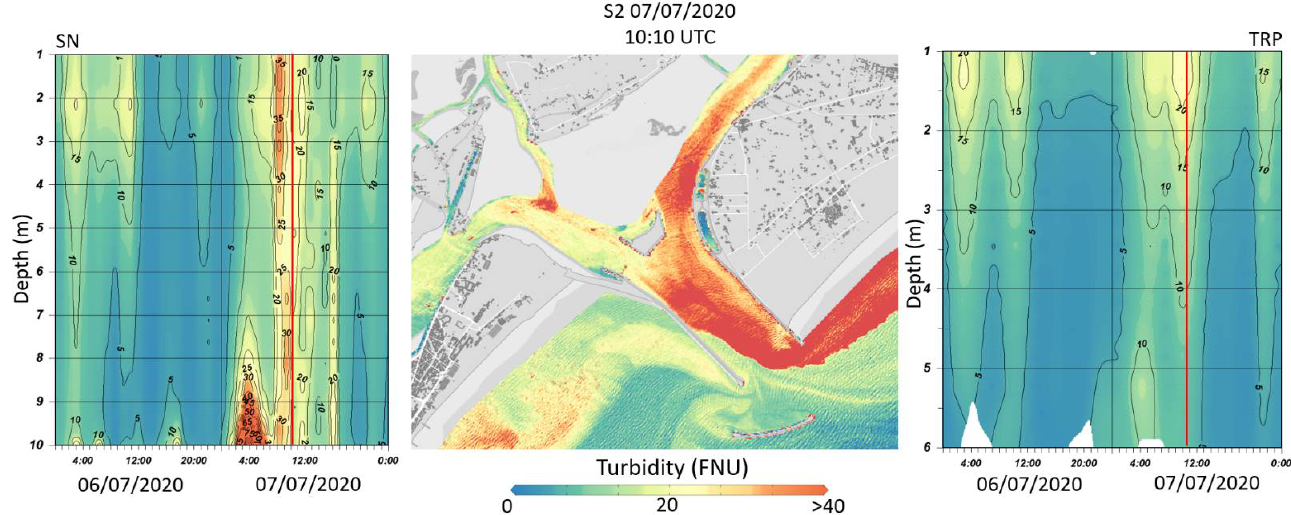
Figure 17. Wind event 6–7 July 2020. ( Central ) panel: satellite-derived turbidity map of the study area for the investigated period. ( Left , right ) panels: time series of turbidity derived from acoustic backscatter of the two bottom-mounted ADCPs along the water column for SN ( left ) and TRP ( right ) stations. Vertical red lines mark the S2 satellite overpass time.